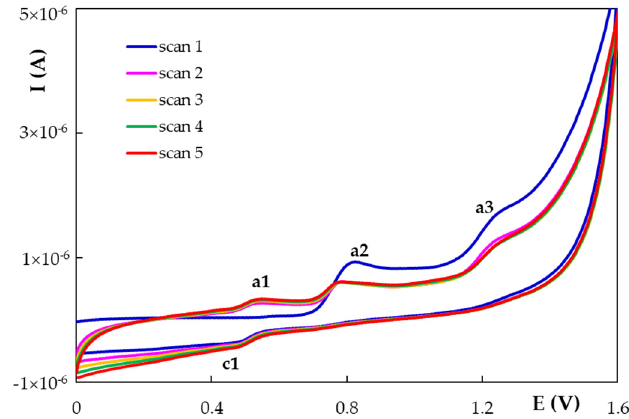
Figure 3. The first five successive cyclic voltammetric scans recorded at H type PGE for 1.00 × 10 − 4 mol/L HESP in BRB solution pH 1.81; scan rate 0.100 V/s.